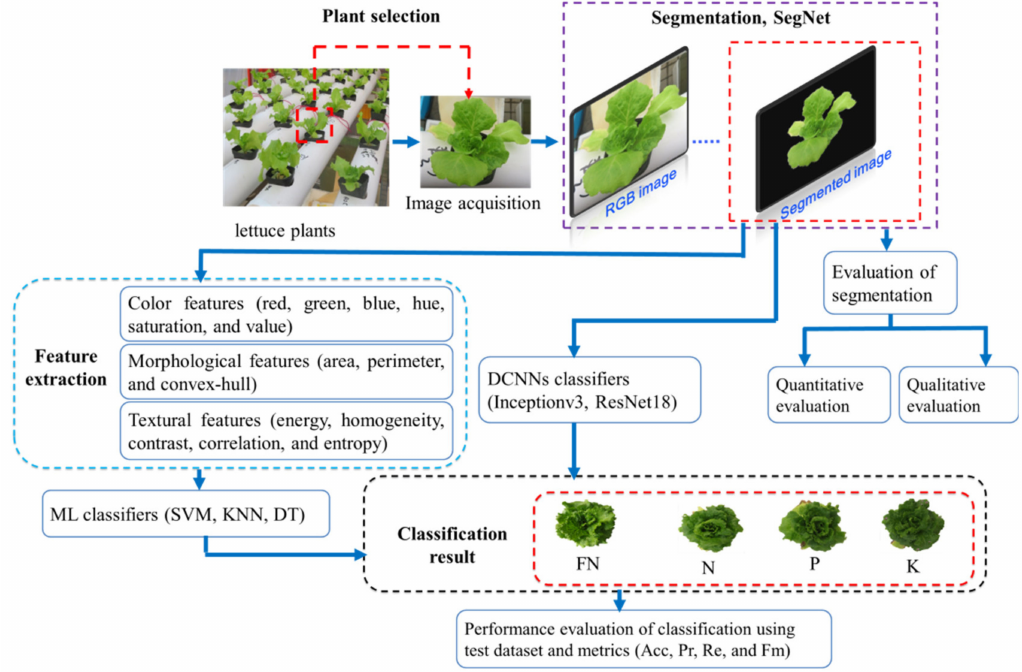
Figure 1. Flowchart of the proposed method of nutrient deficiency diagnosis in lettuce plants grown in aquaponics.